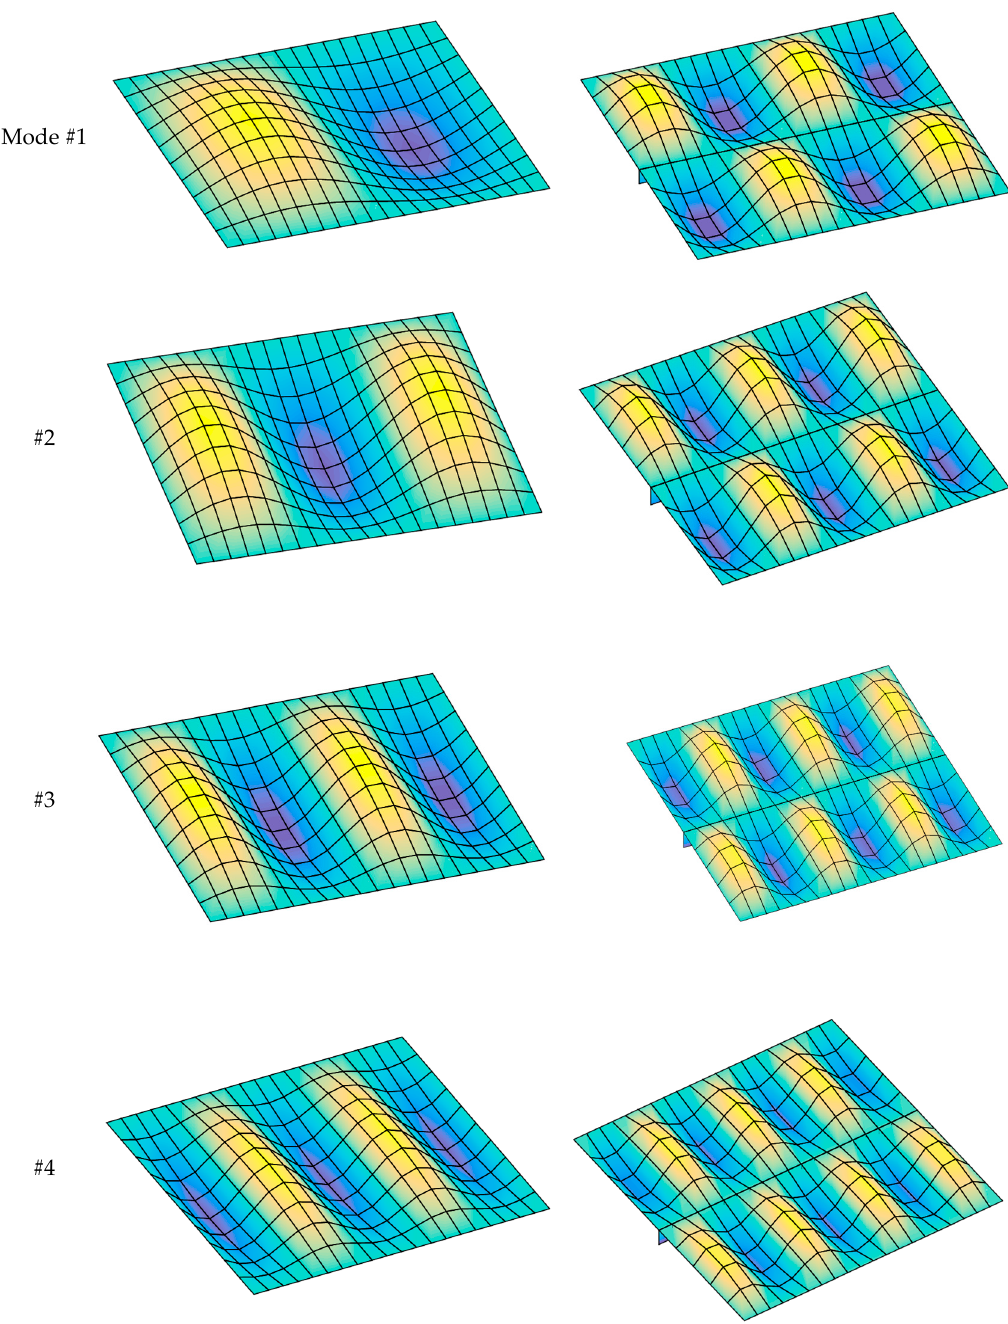
Figure 7. The first four buckling mode shapes of FGM plate with and without a central stiffener ( b / h =50, n =0.5, Si 3 N 4 /SUS304).